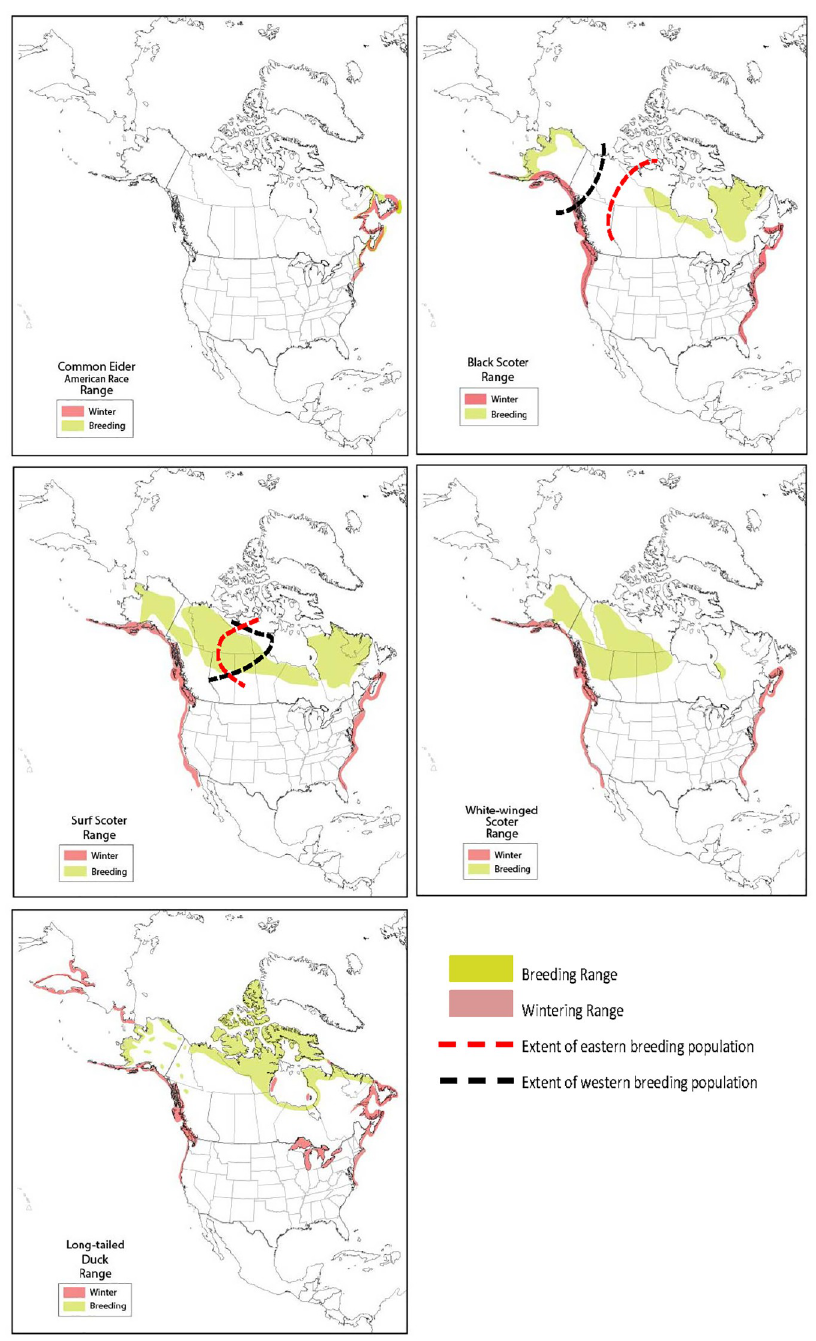
Fig 1. North American breeding and winter ranges of American common eider ( Sometaria mollissima dresseri ), eastern and western populations of black scoter ( Melanitta americana )and surf scoter ( M . perspicillata ), white-winged scoter ( M . fusca ), and long-tailed duck ( Clangula hyemalis ).